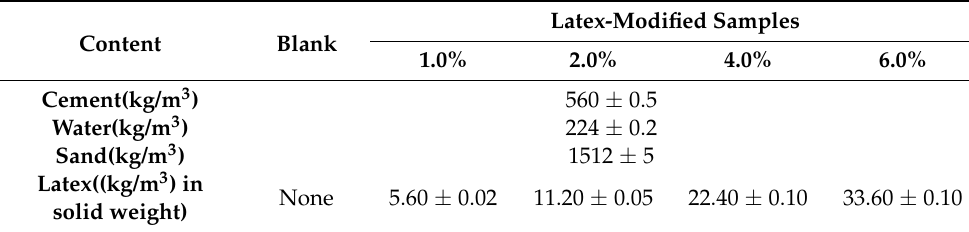
Table 2. Mix design of the latexes and references in cement